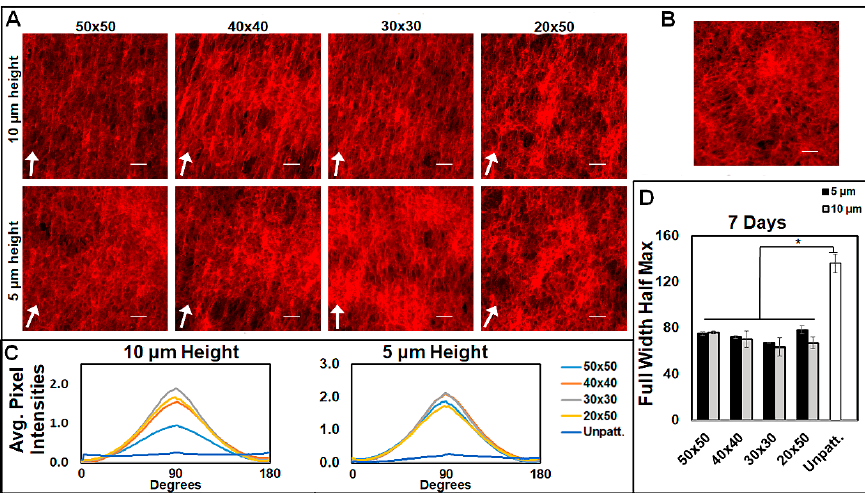
Figure 4. Cell alignment following 7 days of culture compared by pattern height. Cells were cultured on ( A ) patterned and ( B ) unpatterned PDMS for 7 days and visualized with rhodamine phalloidin, with white arrows indicating pattern directions. Scale bar = 100 µ m. ( C ) Fast Fourier transform (FFT) analysis quantified the alignment of confluent cell culture substrates after 7 days for each pattern height. ( D ) Full width half maximums derived from average pixel intensity curves ( C ) for both 5 and 10 µ m. ( C , D ) 10 µ m-height full width half maximums reproduced from Figure 3D,E, n = 3 unique images per condition. Data are presented as mean ± SE, where * p ≤